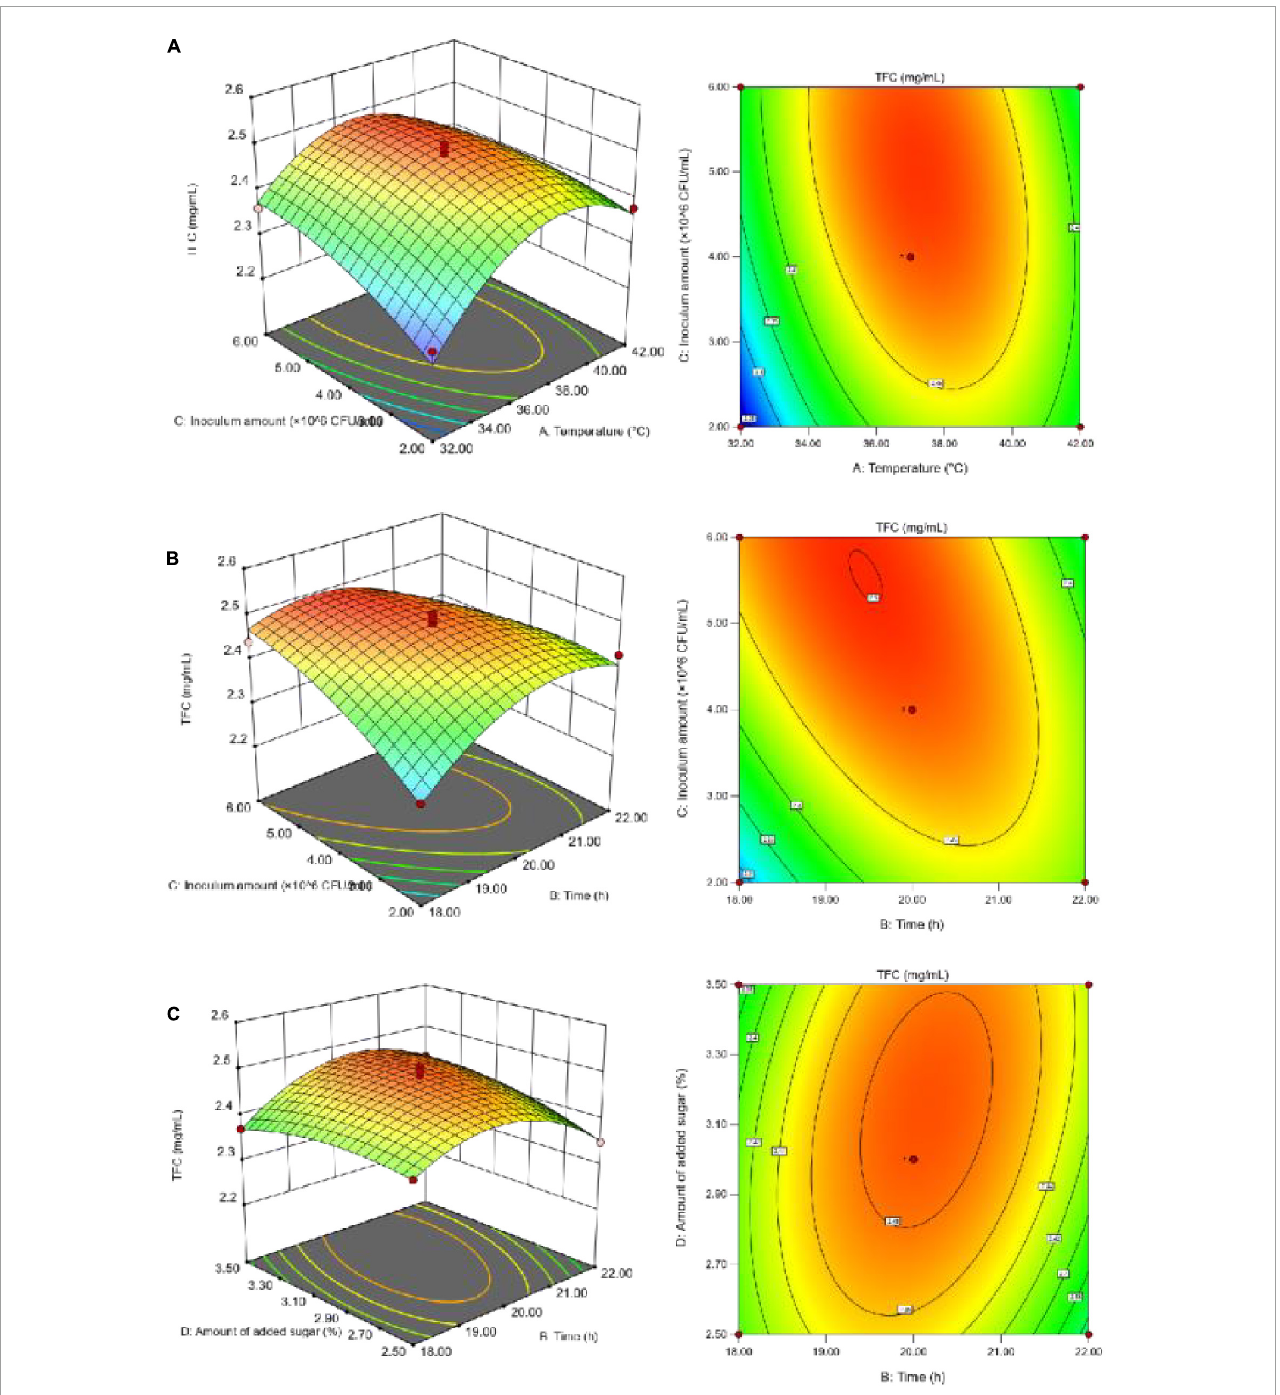
FIGURE4 The effect of interaction on the TFC. (A) The interaction between temperature and inoculum amount; (B) the interaction between fermentation time and inoculum amount; (C) the interaction between fermentation time and sugar addition.